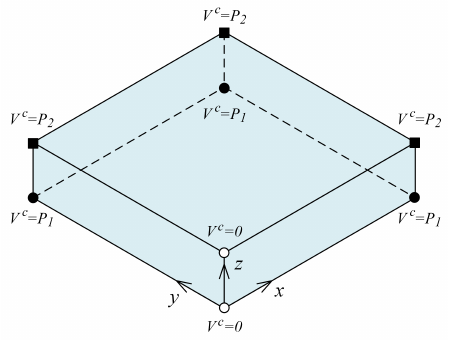
Figure 10. Material parameters for Example 3.